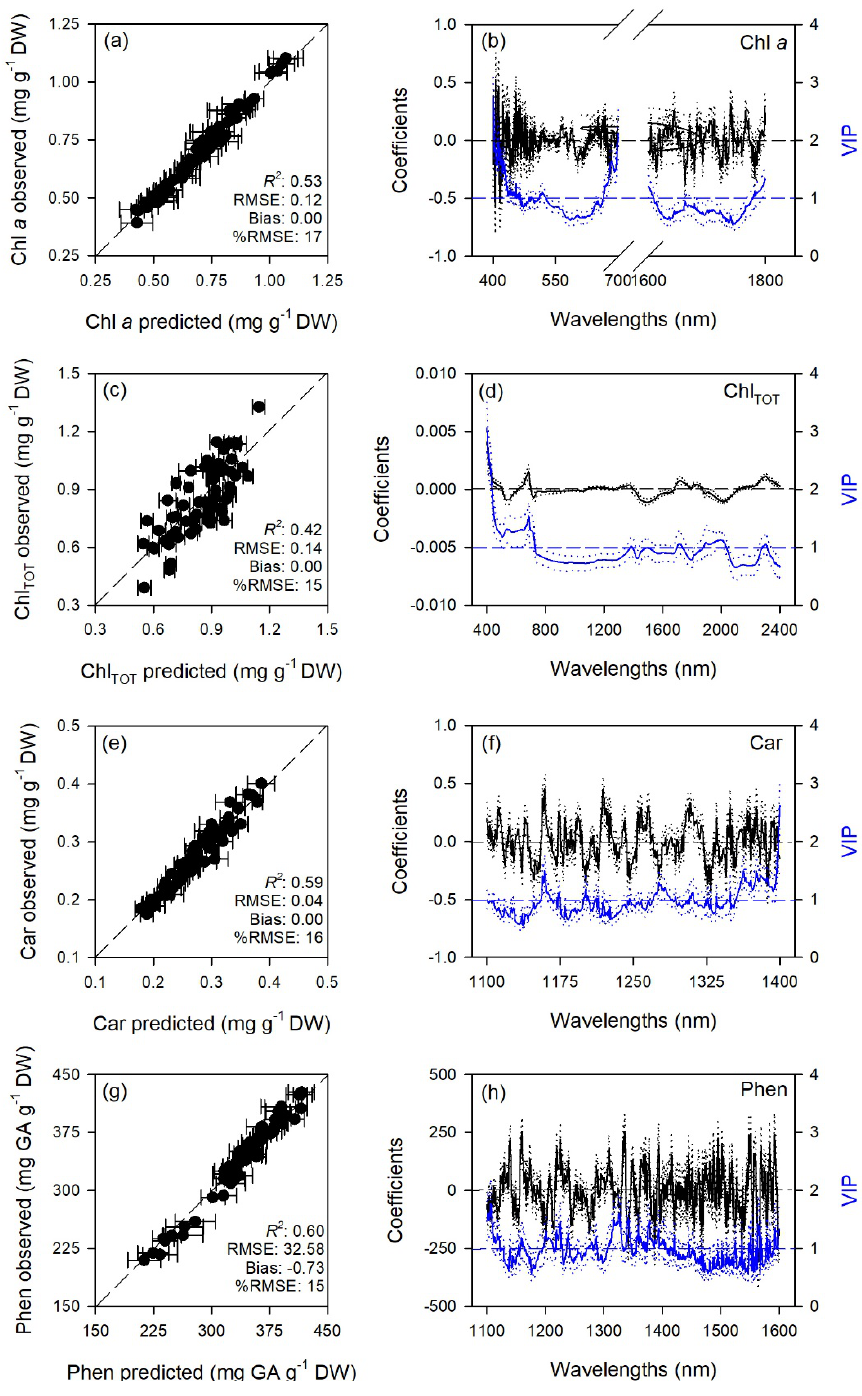
Figure 5. ( a , c , e , g ) Observed versus partial least squares regression (PLSR)-predicted values of chlorophyll a (Chl a ), total chlorophyll (Chl TOT ), carotenoids (Car), and total phenols (Phen) in sage; error bars for predicted values represent the standard deviations generated from 500 simulated models; dashed line is 1:1 relationship; model goodness-of-fit ( R 2 ), root mean square error (RMSE), bias and %RMSE for validation data generated using 80% of the data for calibration and 20% for validation are reported. ( b , d , f , h ) Mean (solid), 5th and 95th percentile (dotted) of standardized coefficients (black), and variable importance for projection values (VIP, blue) by wavelengths for PLSR-models predicting Chl a , Chl TOT , Car, and Phen in sage.